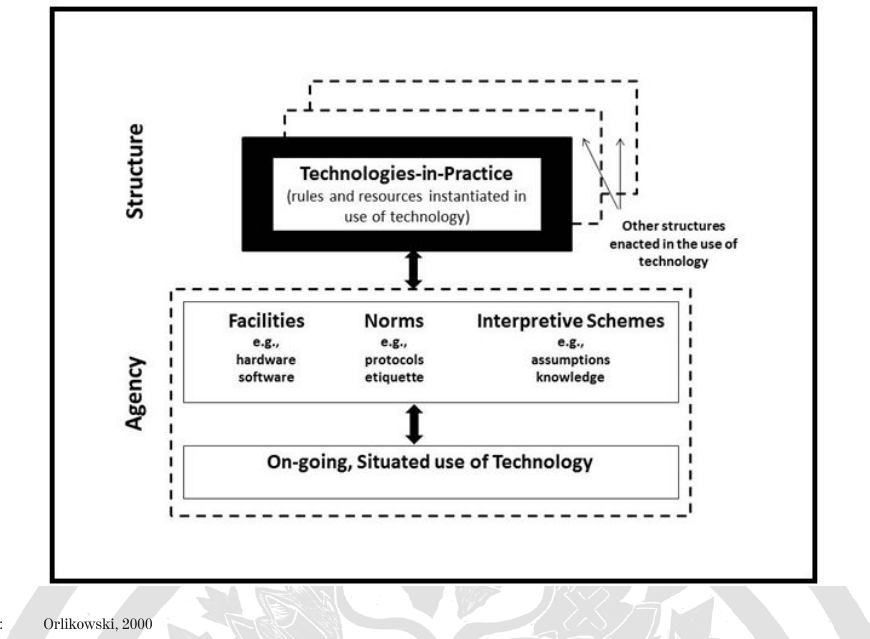
FIGURE 2: ENACTMENT OF TECHNOLOGIES IN